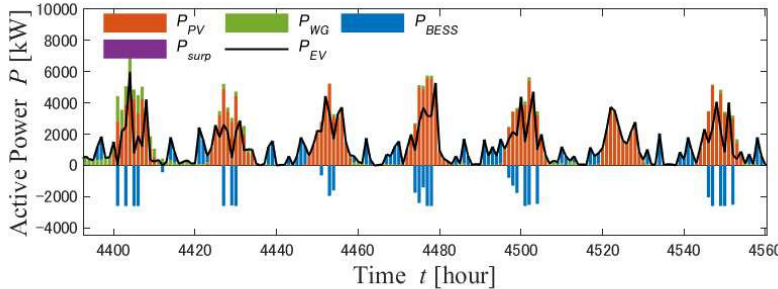
Figure 15. Generated power and load from October 1 to 7 (Case 1).